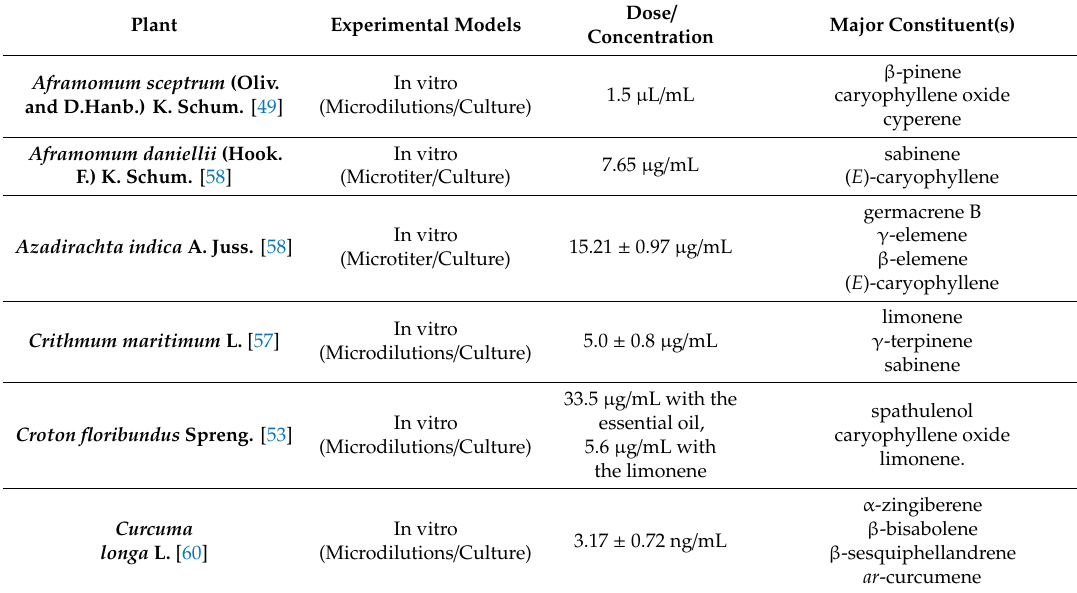
Table 2. Essential oils with trypanocidal activity against T.